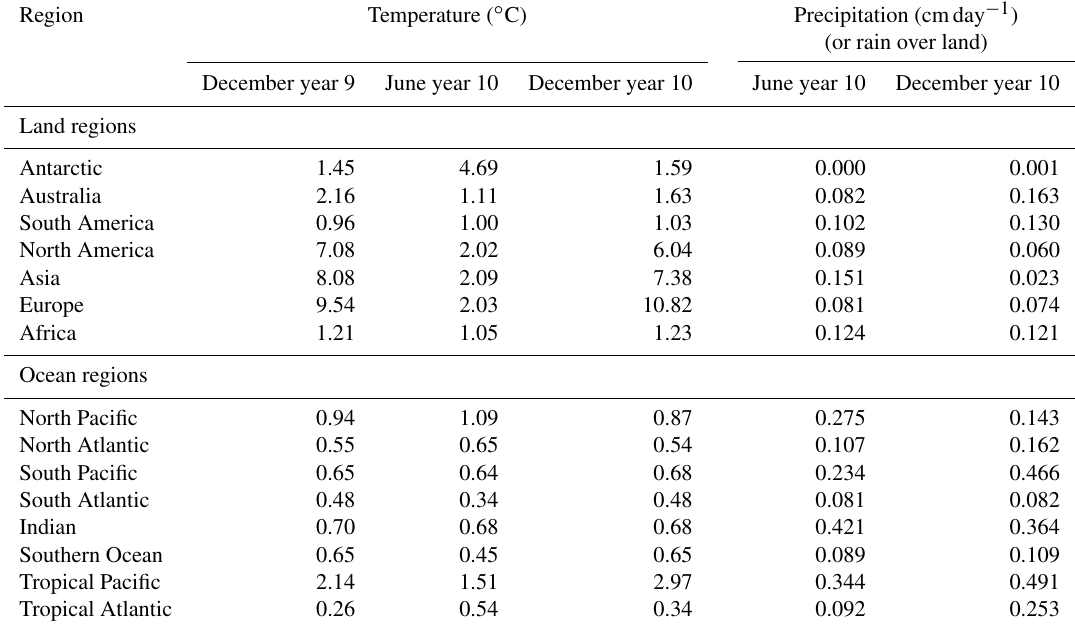
Table 1. Average uncertainty values 2 σ